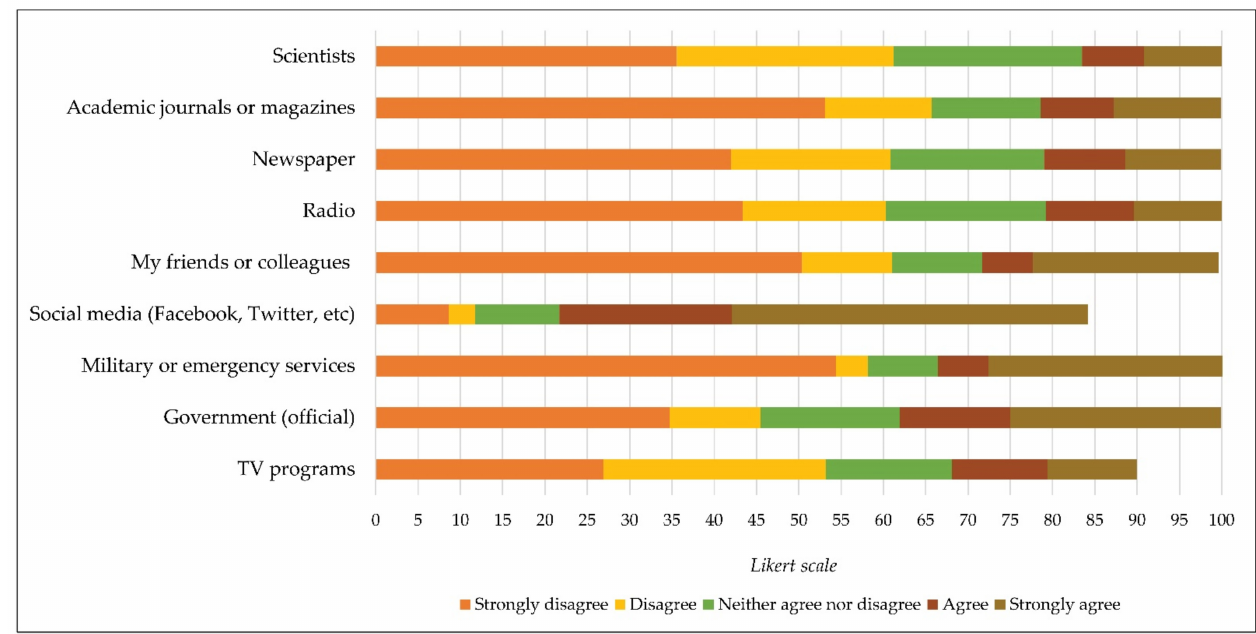
Figure 5. Reasons for fear caused by a coronavirus disease (COVID-19).